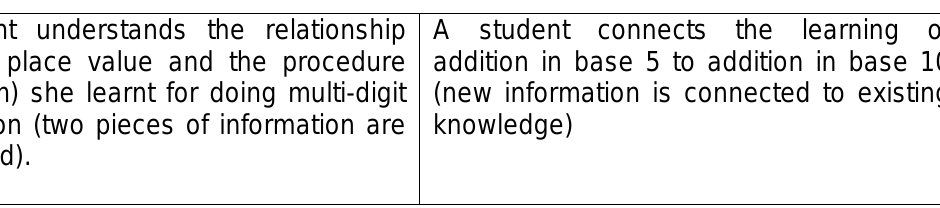
between place value and the procedure (algorithm) she learnt for doing multi-digit subtraction (two pieces of information are